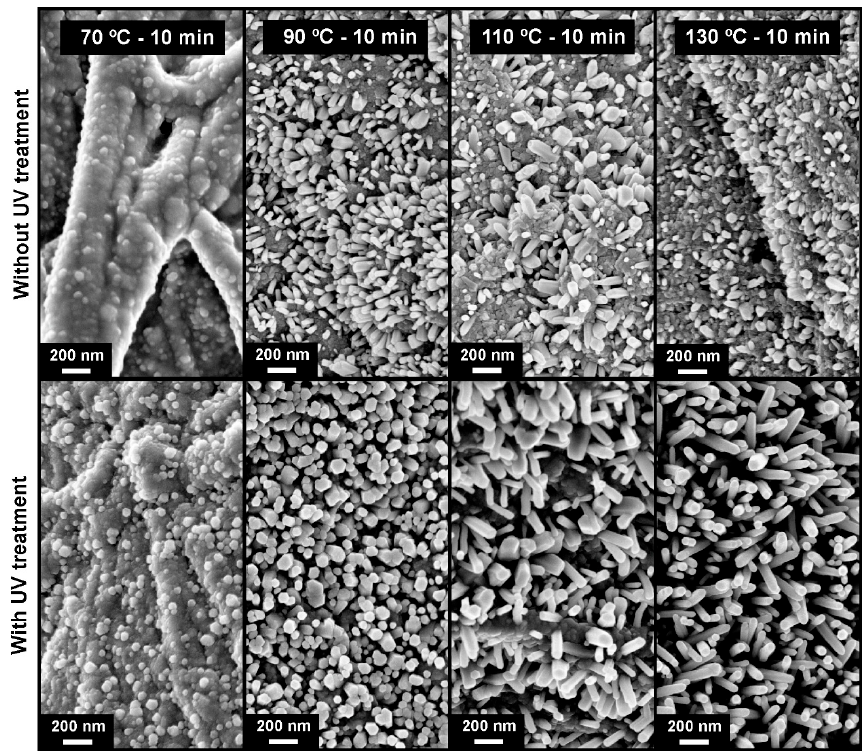
Figure 7. Surface SEM images of ZnO nanorods produced by hydrothermal method assisted by microwave irradiation on Whatman paper, with a synthesis time of 10 min, with different synthesis temperatures (70, 90, 110 and 130 °C). On top are the images of samples produced without UV treatment and on the bottom samples produced with UV treatment.